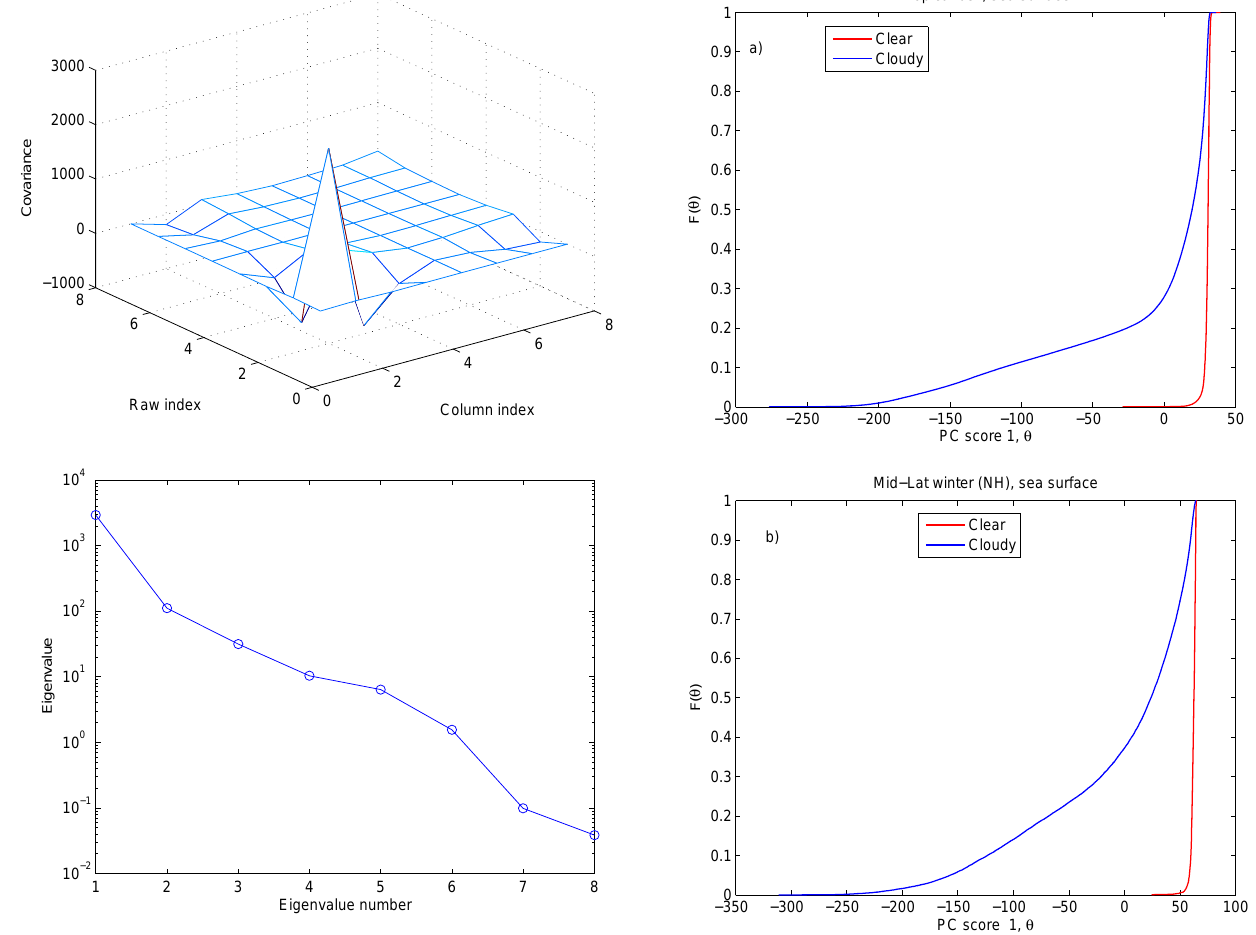
Figure 5. Example of cumulative distribution function, F , of the Fig. 5. Exemple of cumulative distribution function, F , of the 1- Fig. 5. Exemple of cumulative distribution function, F , of the 1- first PC score of the statistic vector x (Eq. 10) over sea surface. st PC score of the statistic-vector x (Eq. (10)) over sea surface. a) (a) tropical climatic zone; (b) mid-latitude winter (NH) climatic st PC score of the statistic-vector x (Eq. (10)) over sea surface. a) tropical climatic zone; b) mid-latitude winter (NH) climatic zone. tropical climatic zone; b) mid-latitude winter (NH) climatic zone.